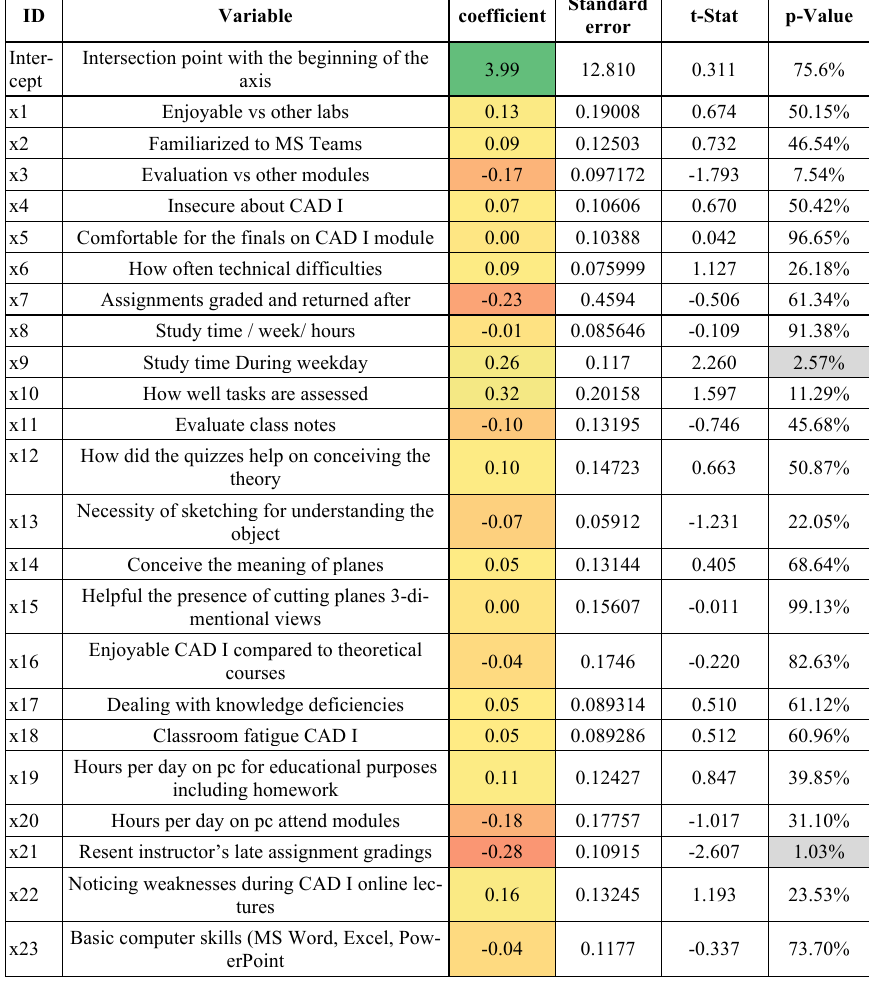
Table 2. Coefficients, mean standard error, t-test, p-values derived from the correlation analy- sis for the examined independent 35